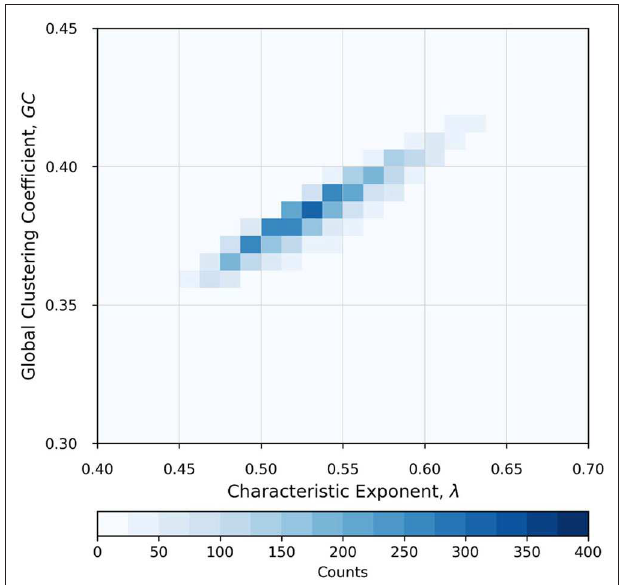
FIGURE 7 | Two-dimensional histogram plot showing a strong relationship between characteristic exponent, λ , and global clustering coefficient, GC , for all stations and all years pooled together. The color code represents the number of pairs of λ and GC values in any pixel. It is apparent that all stations exhibit λ > λ rand = 0.41. Virtually all values of GC > 0.345 (Braga et al., 2016), suggesting that the streamflow process for the entire Iowa region at a daily time scale has its origin in the long-range correlated (persistence) stochastic process. Note that as λ increases, GC also increases, as expected when the process becomes more and more linear.